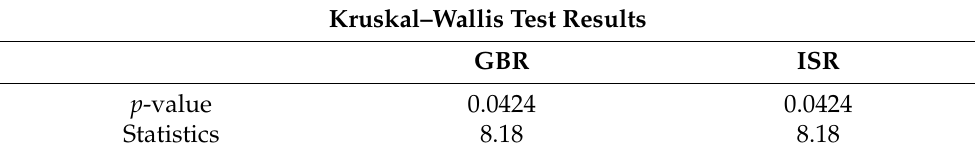
Table 8. Kruskal–Wallis test results for GBR and